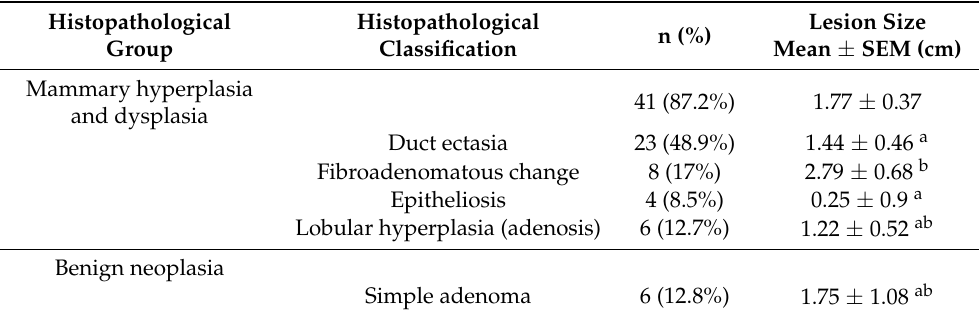
Table 4. Histopathologic findings of the 47 lesions analyzed.